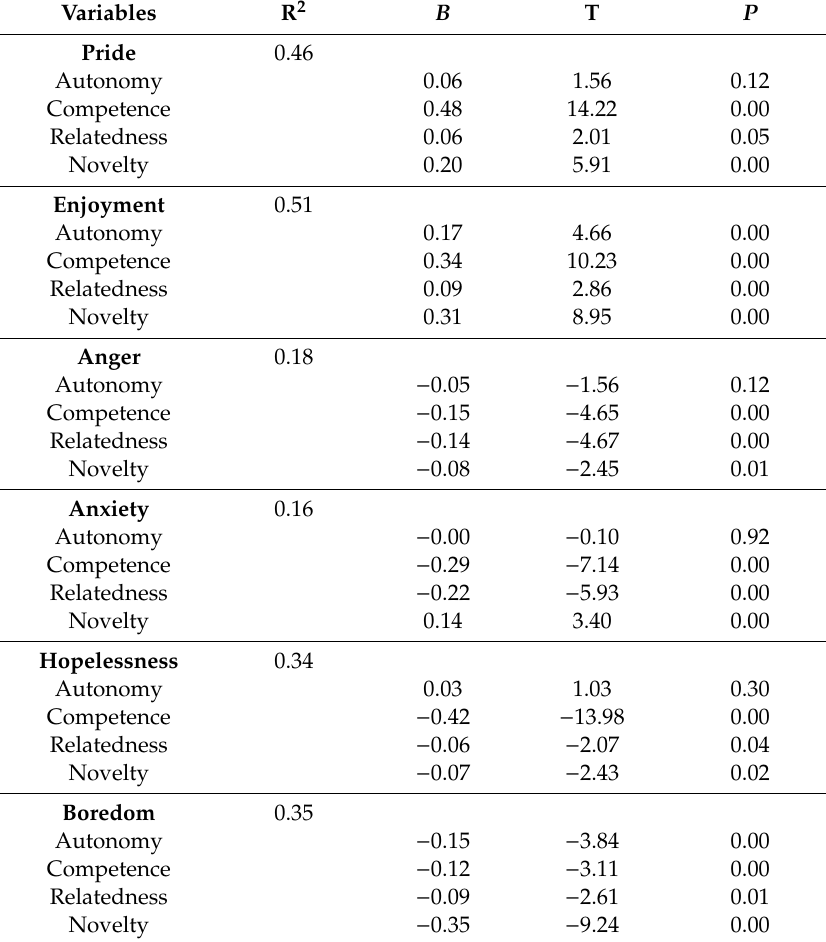
Table 5. Results of regression